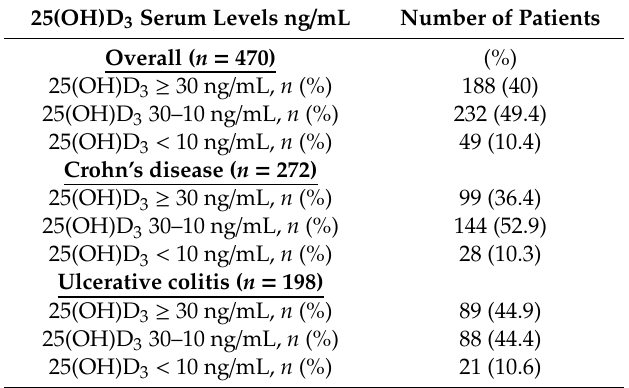
Table 2. 25-hydroxyvitamin D (25(OH)D 3 ) serum levels in inflammatory bowel disease (IBD)